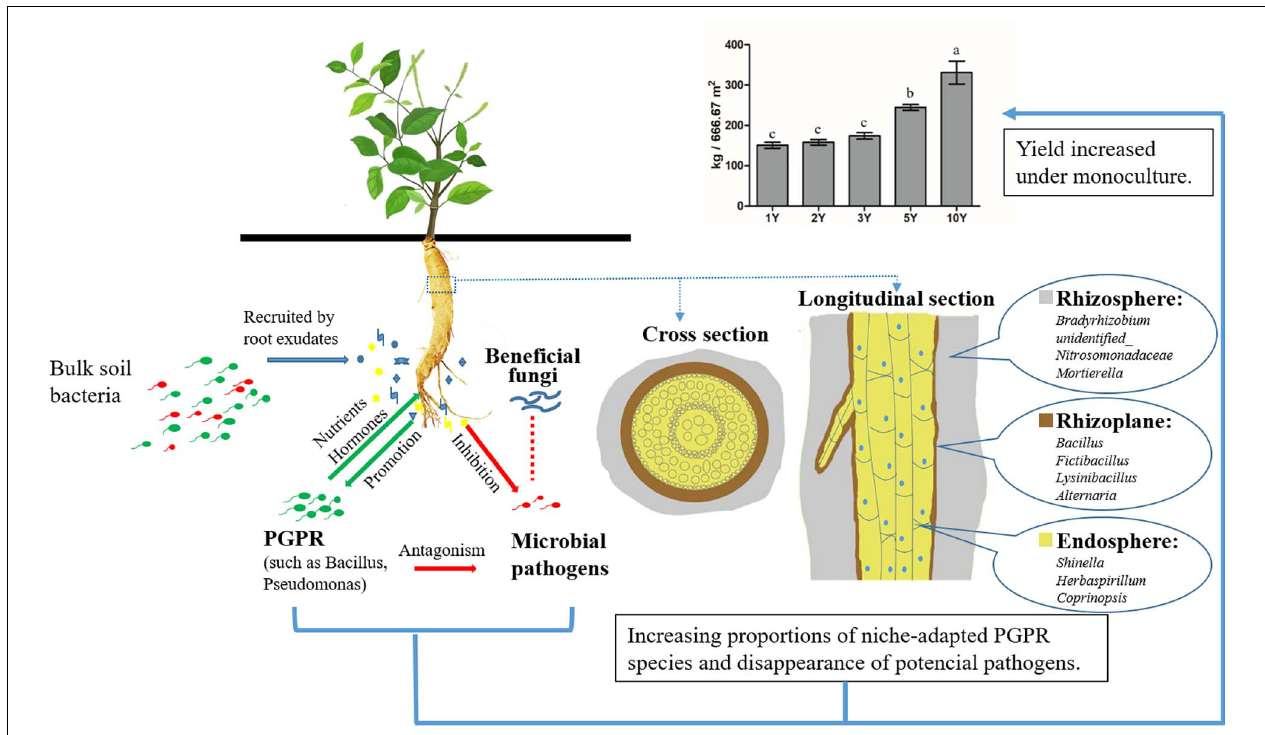
FIGURE 8 | Schematic representation of microbiome interactions and eco-niche distribution in three rhizocompartments of A. bidentata in a consecutive monoculture system. The red dotted line represented that no experiments have been obtained in vitro